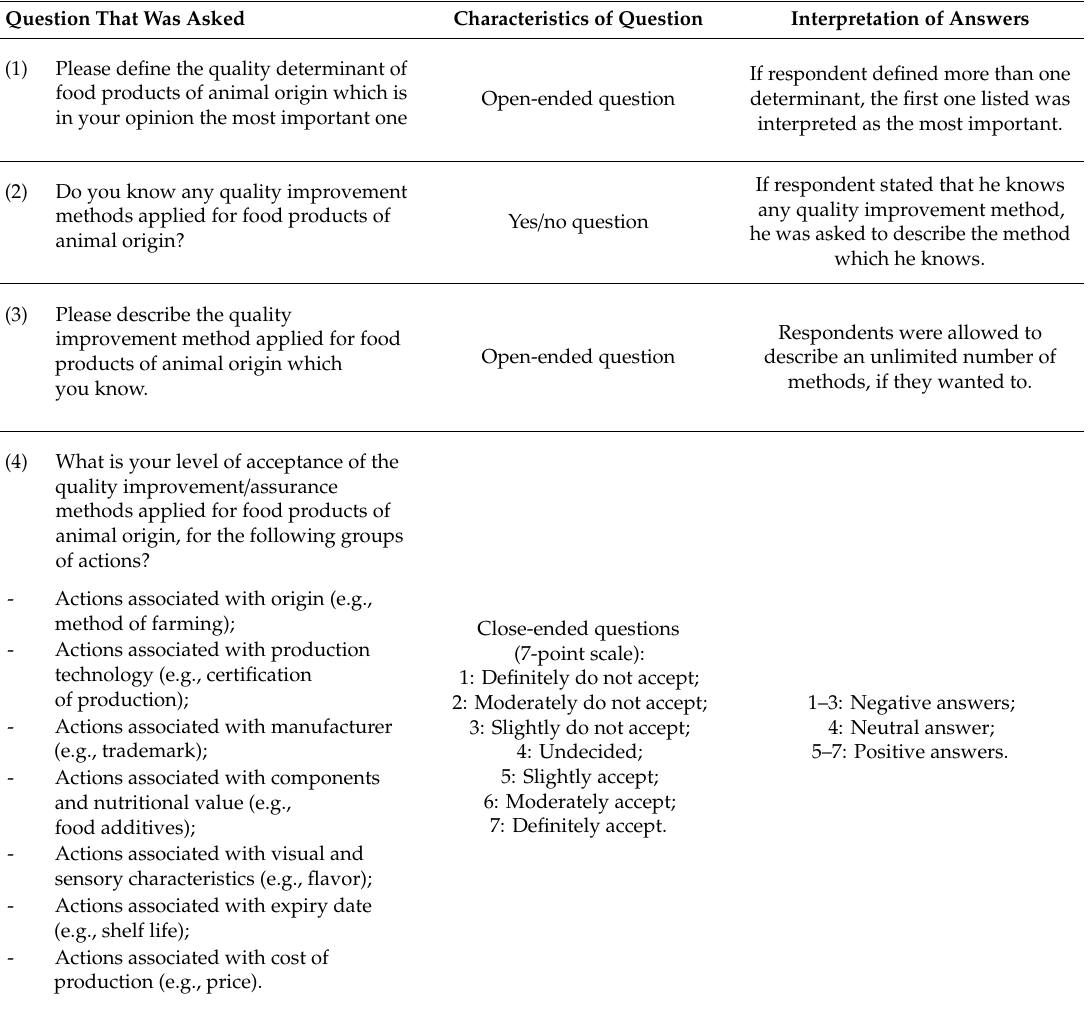
Table 2. The questionnaire applied in the